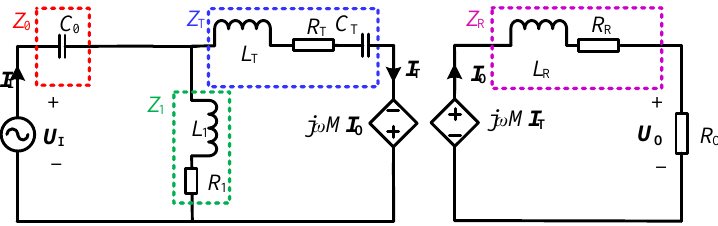
Figure 2. Equivalent circuit diagram of the CLC/N compensated WPT